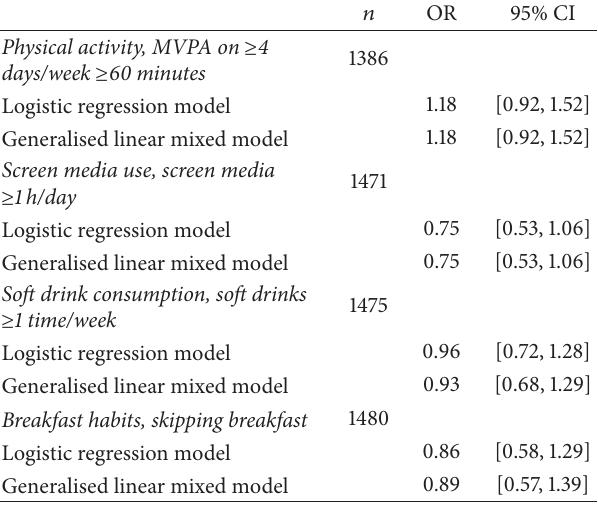
Table 1: Comparison of the results derived from logistic regression models and generalised linear mixed